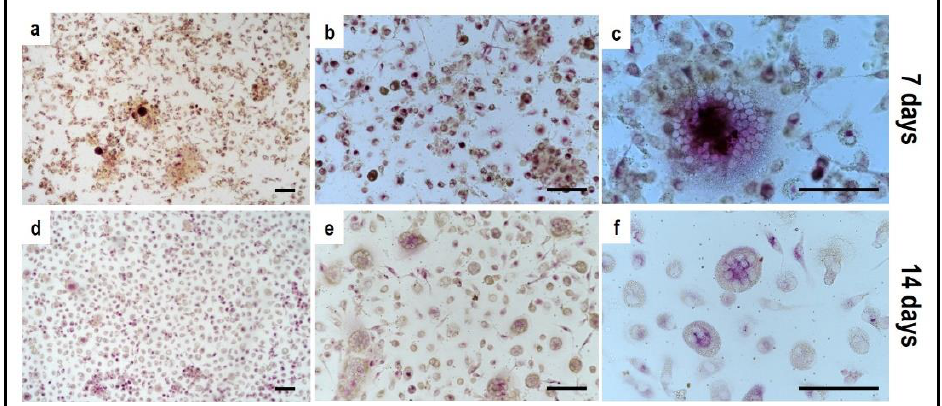
Figure 9. Microphotographs of PBMCs derived from the single-culture induced with M-CSF and RANKL, stained for Tartrate-Resistant Acid Phosphatase (TRAP) at 7 and 14 days. ( a – c ) control culture at 7 days, ( d – f ) control culture at 14 days. Scale bar: 100 µm.